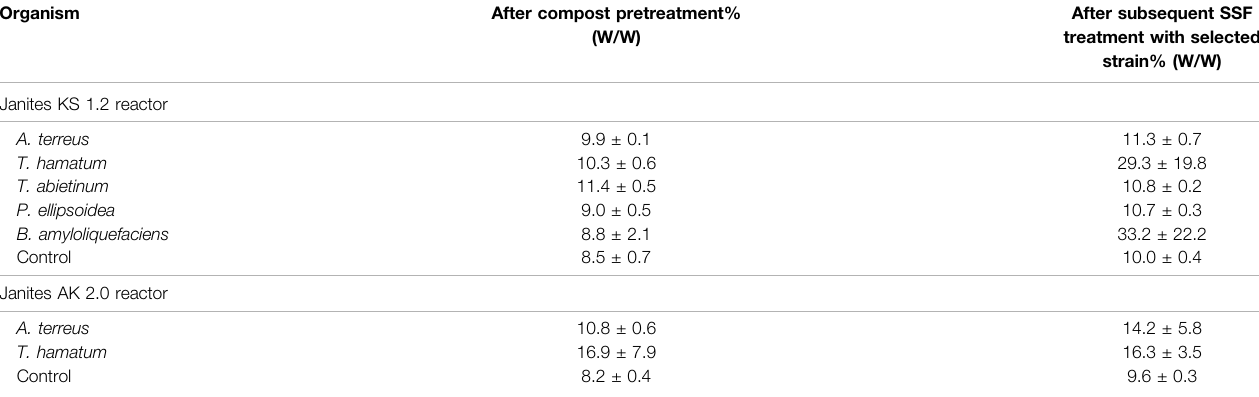
TABLE 4 | Mass-reduction of PVC fi lm during the compost pretreatment and a subsequent treatment with selected fungal and bacterial strains under SSF conditions in KS 1.2 and AK 2.0 reactors. Organism After compost pretreatment%